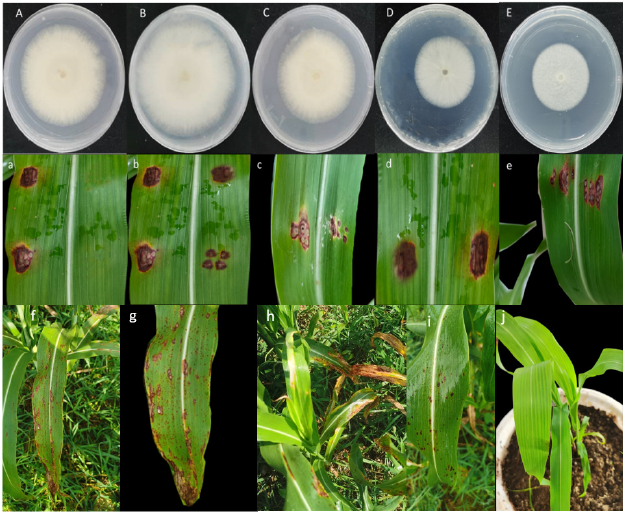
Figure 1. Pathogenicity assays. Five isolates caused spots consistent with symptoms in the field. ( A – E ) correspond to ( a – e ); ( f – i ) symptoms in the field; (j) control.